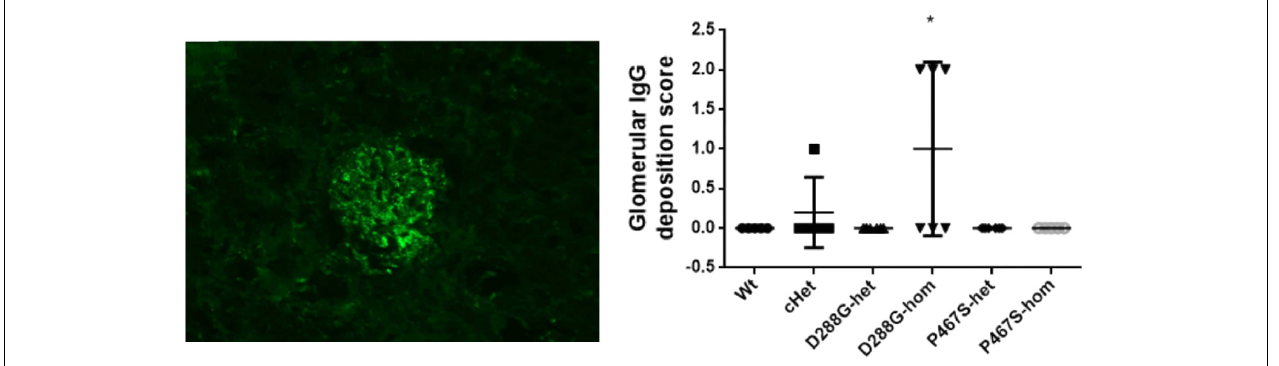
FIGURE 6 | Examination of IgG deposition in the kidneys of the mice treated by LPS. An example of IgG staining pattern in a glomerulus (left), and the quantification and comparison of IgG intensity in the mice in the 6 groups. Wt, n = 5; cHet, n = 5; D288G-het, n = 6; D288G-hom, n = 6; P467S-het, n = 6; P467S-hom, n = 5. * p = 0.052 vs. wt according to the Kruskal-Wallis test.